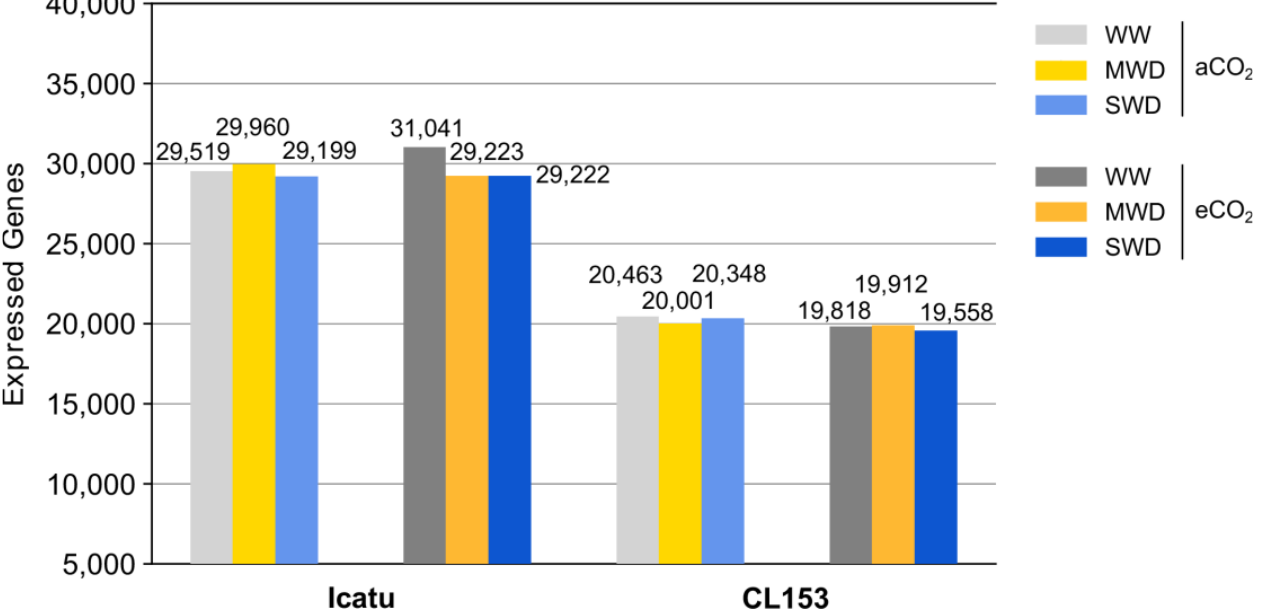
Figure 1. Total number of expressed genes in Icatu and CL153 plants grown under different watering conditions (well-watered, WW; moderate water deficit, MWD; and severe water deficit, SWD), and under ambient air 380 μL L −1 [CO 2 ] (aCO 2 ) or elevated 700 μL L −1 [CO 2 ] (eCO 2 ), at 25/20 °C.